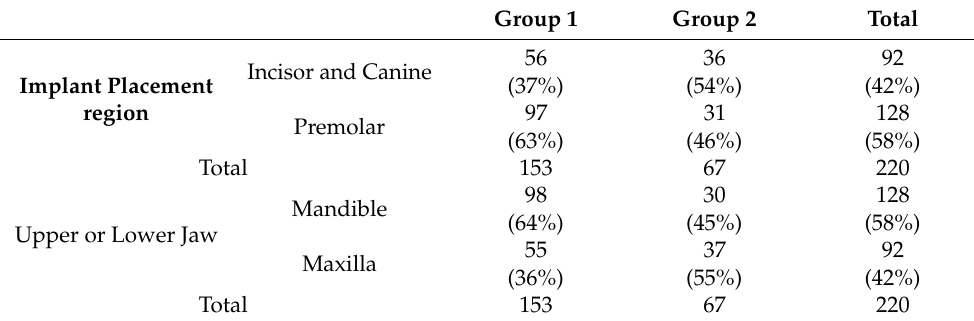
Table 3. Frequency of implant distribution by implant site in Group 1 and Group 2.